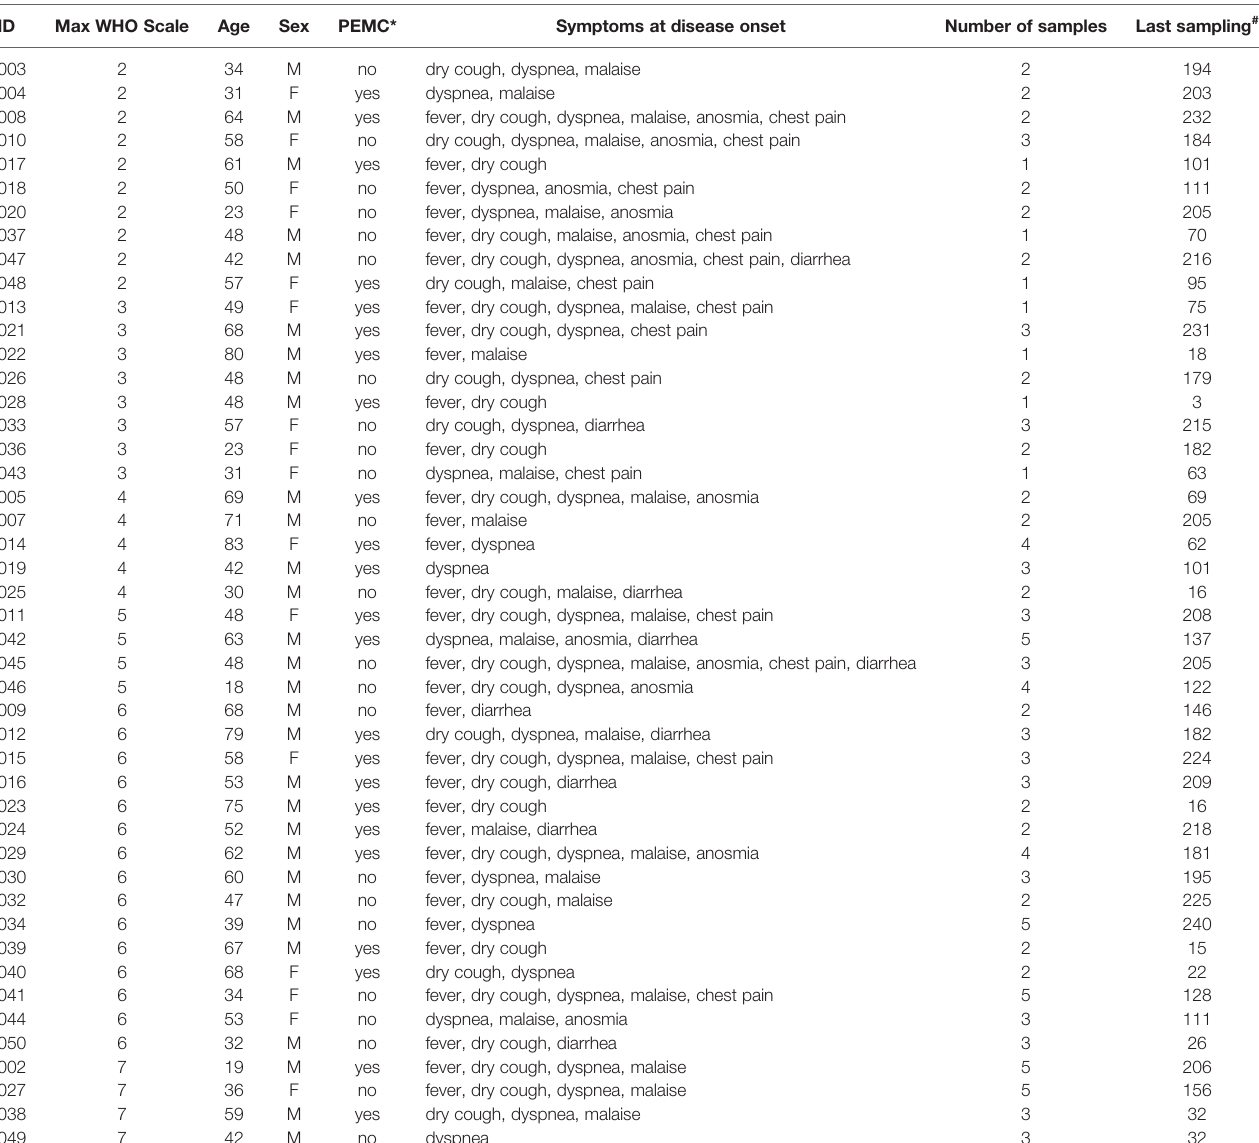
TABLE 1 | Patients ’